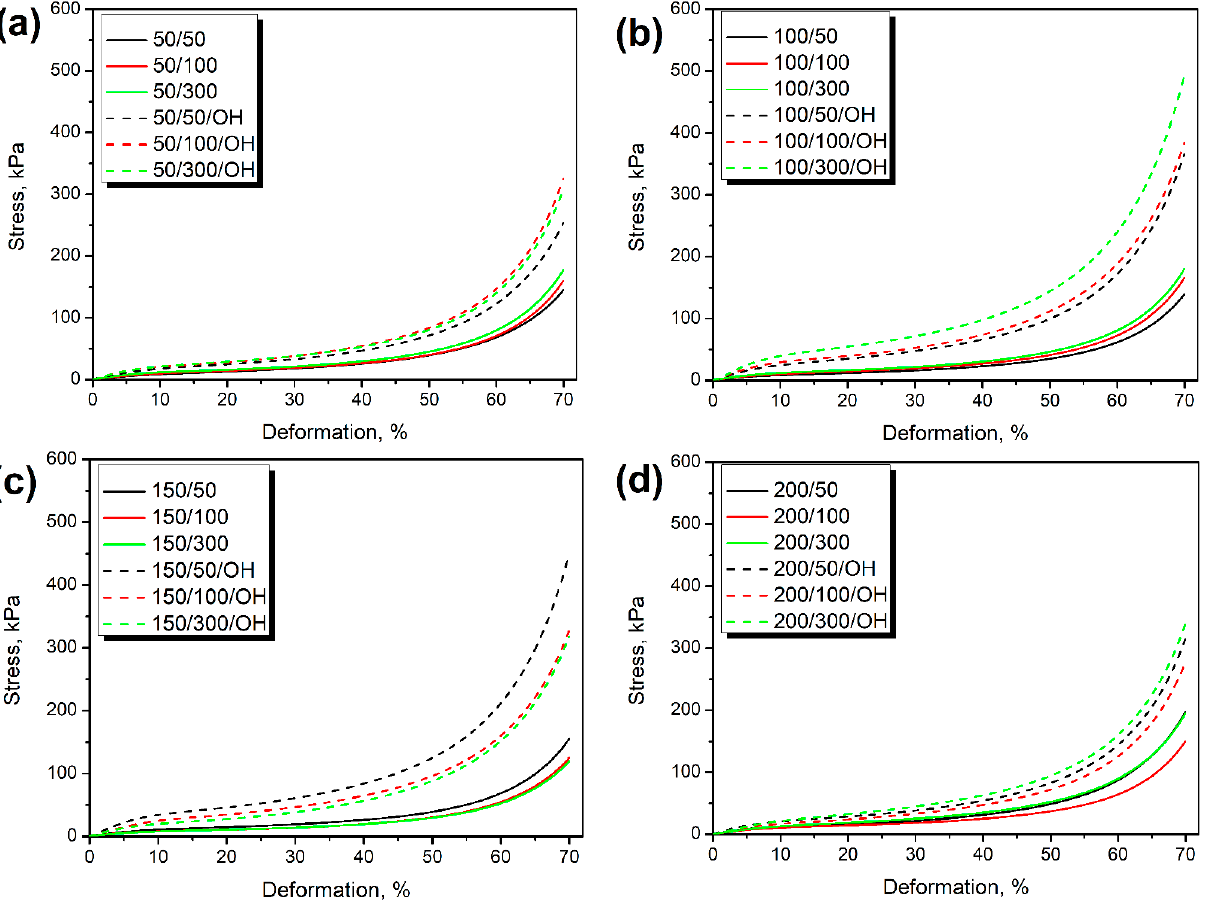
Figure 4. Stress-deformation curves of composite foams containing GTR modified at ( a ) 50 °C, ( b ) 100 °C, ( c ) 150 °C, and ( d ) 200 °C.